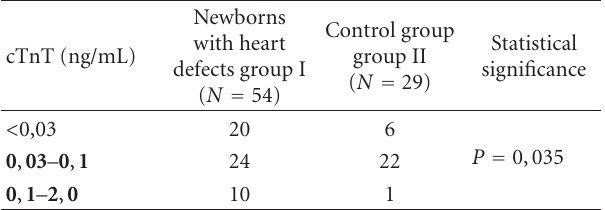
Table 2: Number of patients with particular cTnT concentration ranges in studied